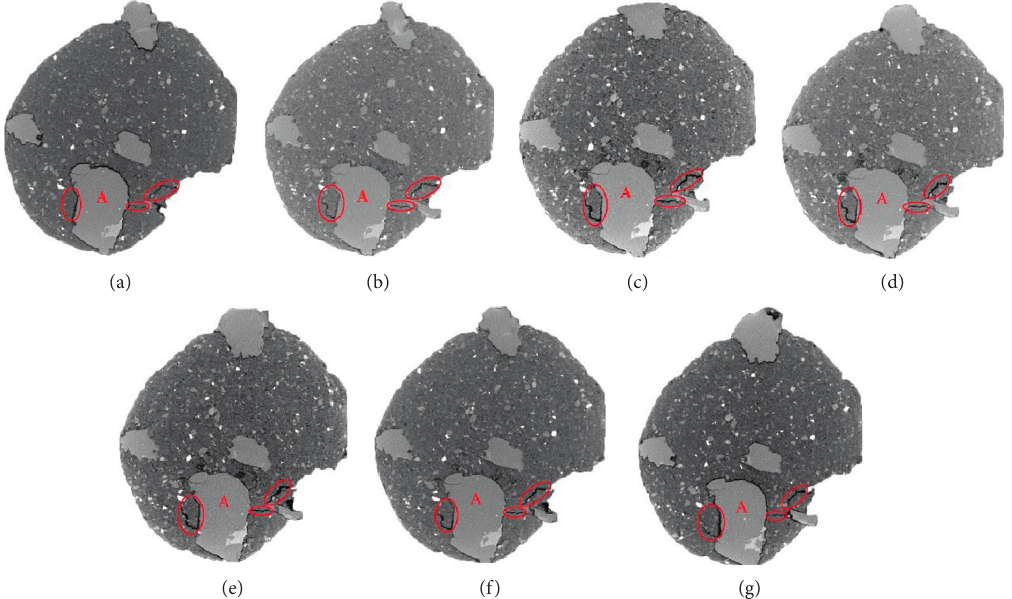
− ” means contraction).